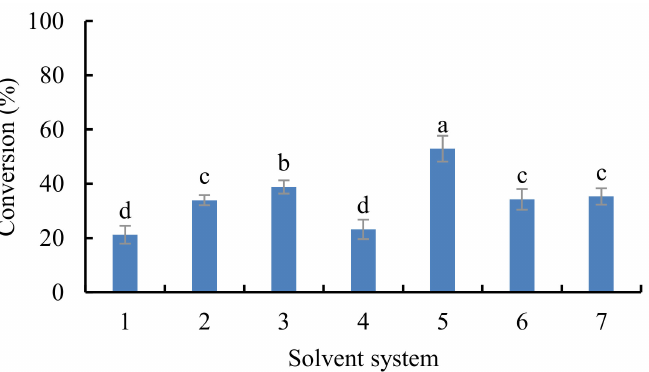
Figure 2. Conversion of EGCG by different solvent systems (reaction conditions: EGCG, 1 mmol; vinyl stearate, 3 mmol; enzyme, 5.0% lipase DF “Amano” 15 ( w / w of both substrates)); reaction temperature, 50 ◦ C; reaction time, 48 h in different solvent systems. 1: methanol; 2: ethanol; 3: isopropanol; 4: isopentanol; 5: acetonitrile; 6: acetone; 7: ethyl acetate. Bars with different letters are significantly different at p <